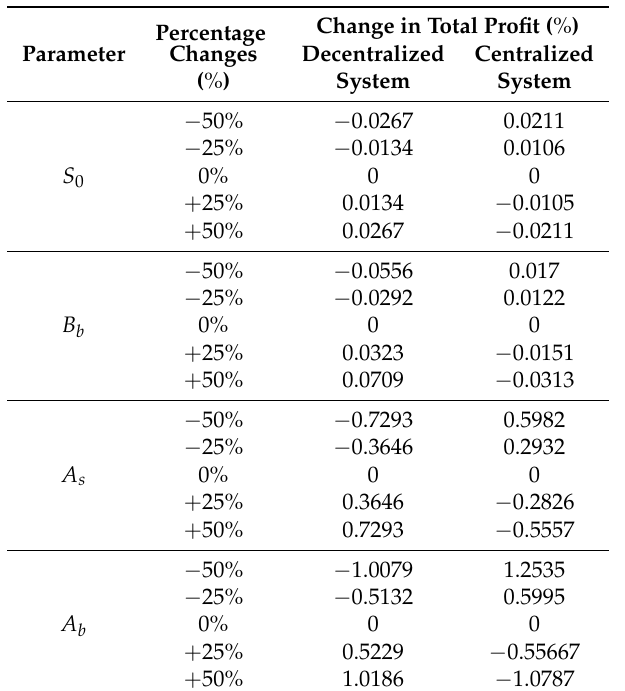
Table 6. Sensitivity analysis for numerical problem 1, in case of unreliable seller.